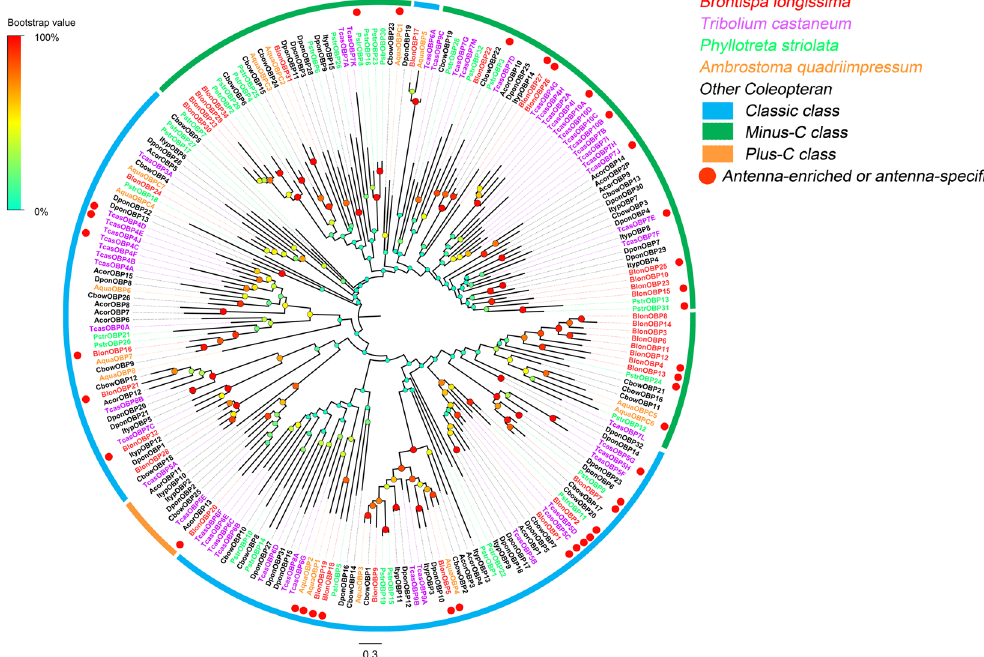
Figure 5. Phylogenetic tree of candidate OBPs from B. longissima (red labels), T. castaneum (purple labels), A. quadriimpressum (orange labels), P . striolata (green labels) and other coleopteran insects (black labels). Antennae-rich OBP in B. longissima are indicated by red dots. The tree was constructed using MEGA (v.6.0) with the WAG + G substitution model and NNI topology search, based on an amino acid alignment by MAFFT. Branch support (circles at the branch nodes) was estimated using an approximate likelihood ratio test based on the scale indicated at the top left. Bars indicate branch lengths in proportion to amino acid substitutions per site. OBP prefixes indicate the following: Acor, A . corpulenta ; Aqua, A . quadriimpressum ; Blon, B . longissima ; Cbow, C . bowringi ; Dpon, D . ponderosae ; Ityp, I . typographus ; Pstr, P . striolata ; Tcas, T . castaneum